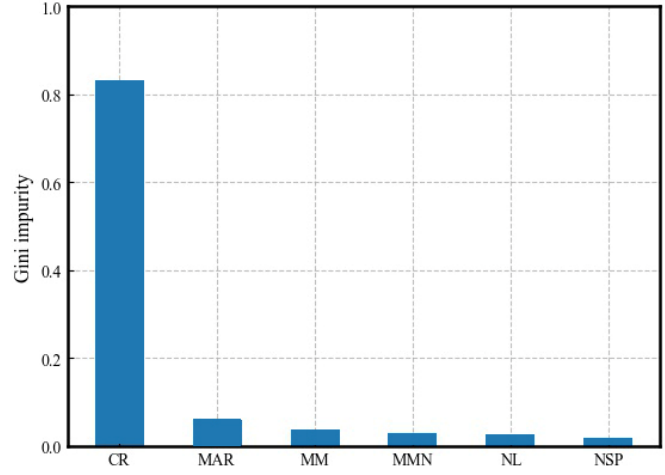
Figure 7. Ranking the importance of features .